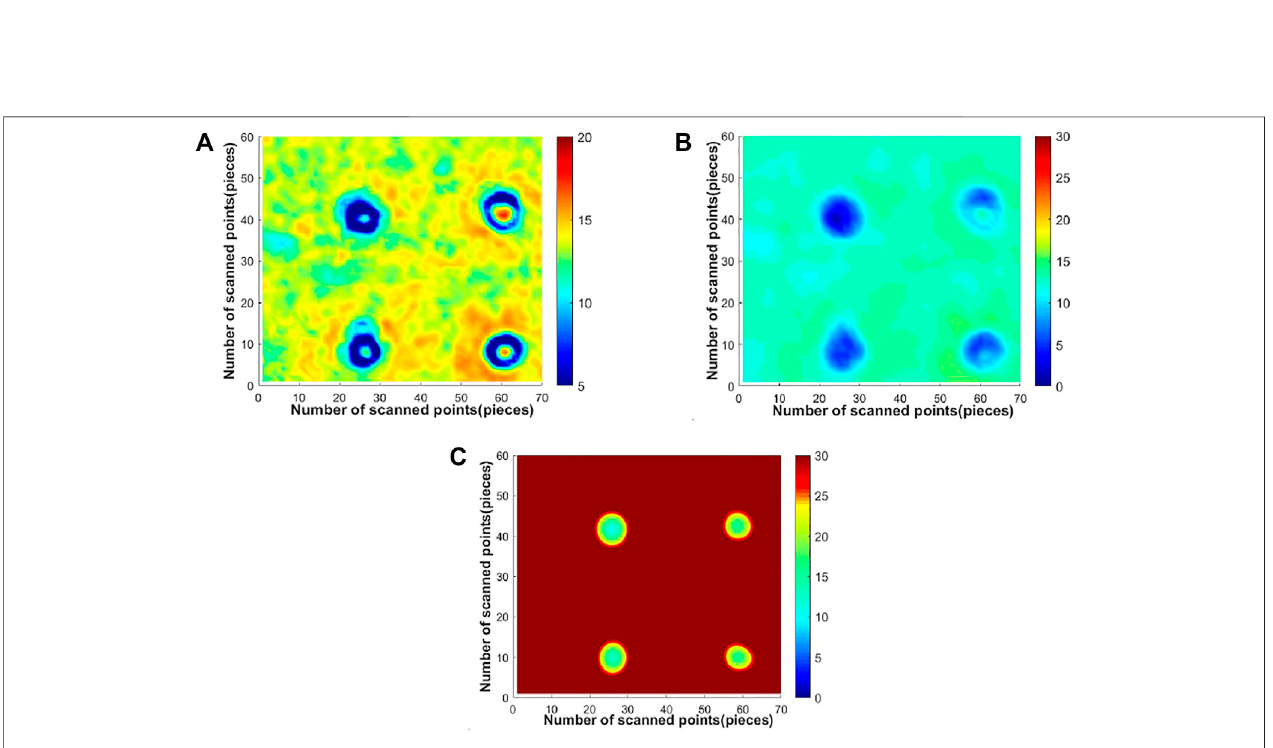
FIGURE 9 | Image of processing results of each method for adhesive debonding with a diameter of 10.0 mm in sample 3. (A) image of original detection, (B) Gaussian fi ltering, (C) method in this paper.